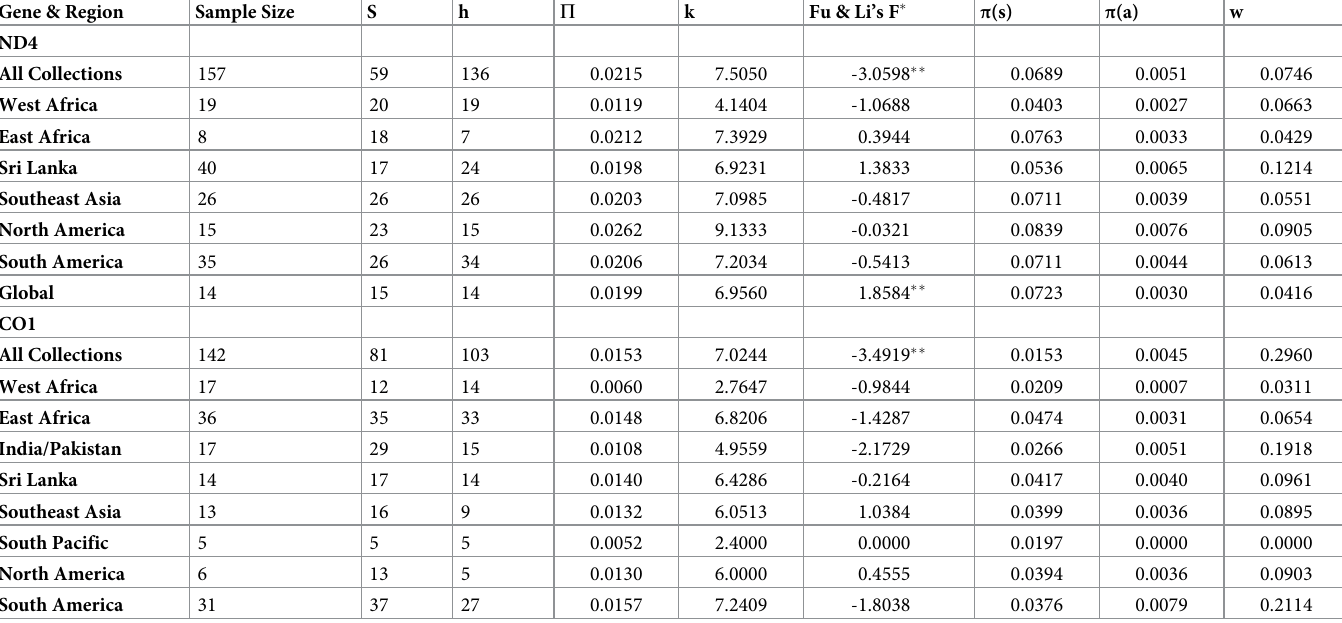
Table 2. Genetic variability in ND4 and CO1 were evaluated by examining the number of substitutions (S), haplotypes (h), nucleotide diversity ( π ) [31], average number of nucleotide differences, k [32] and Fu and Li’s F �